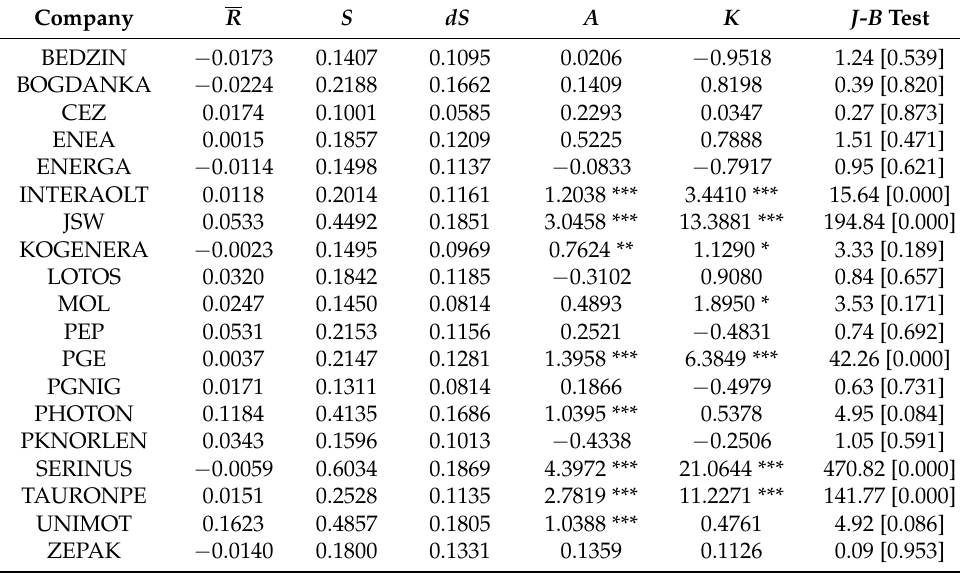
Table 4. Summary statistics of energy companies’ quarterly